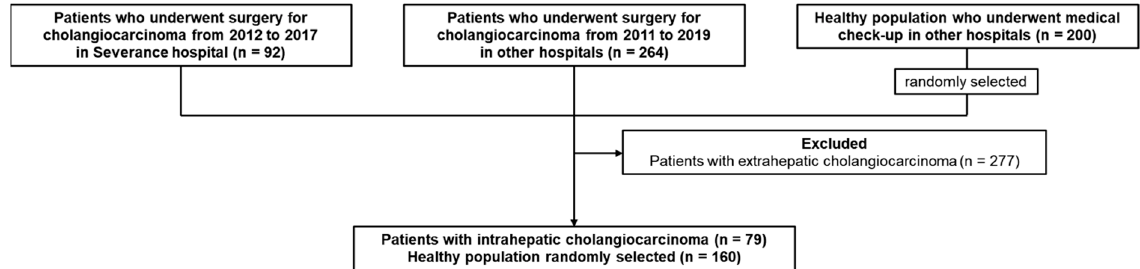
Figure 1. Study flowchart. We collected blood samples of 92 patients with CCC from the Severance hospital. Two hundred and sixty-four blood samples of patients with CCC and 200 blood samples of healthy individuals were collected from other hospitals in the Korea Biobank Network. A total of 277 patients with ECC were excluded and 79 patients with ICC were remained. Of the total 200 healthy individuals, 160 were randomly selected corresponding to two times the number of ICC patients. ICC